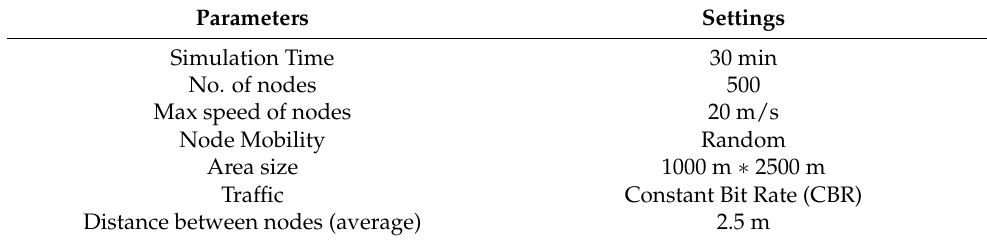
Table 2. Configuration